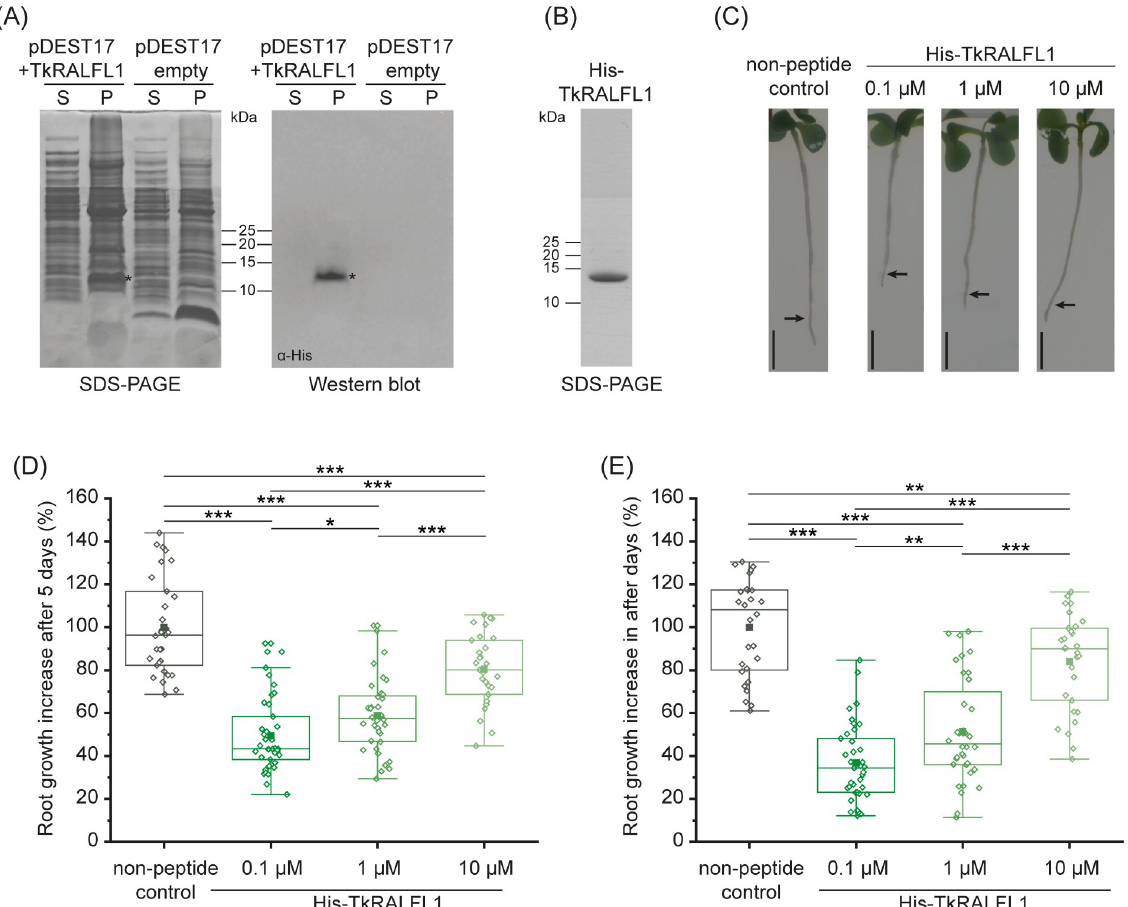
Fig 2. Effect of TkRALF1 produced in E . coli on primary root growth. (A) SDS-PAGE and subsequent western blot analysis (with a His-tag specific antibody) of total protein from E . coli BL21 transformed with either the vector containing His-TkRALFL1 or the empty vector control. For western blot analysis, proteins were transferred to a PVDF membrane and probed using a His-tag specific antibody conjugated to horseradish peroxidase. S, soluble protein phase; P, insoluble protein phase; SDS-PAGE stained with Coomassie Brilliant Blue. The asterisk indicates the additional band in the insoluble phase of E . coli transformed with the expression vector containing His-TkRALFL1. (B) SDS-PAGE analysis of the TkRALFL1 peptide after Ni-NTA affinity purification and subsequent dialysis in order to promote the refolding of the peptide. Gel stained with PageBlue Protein Staining Solution. (C) Representative T . koksaghyz wild-type seedlings from the root growth assay 5 days after transfer to the medium containing different concentrations of TkRALFL1 peptide, that are indicated above the images. Pure buffer was used as non-peptide control. The arrow indicates the position of the root tip at the time of transfer; scale bar = 5 mm. (D) Root growth increase of the primary root of T . koksaghyz wild-type seedlings after treatment for 5 days with different concentrations of exogenous mature TkRALFL1 peptide dissolved in buffer (0.1% (v/v) formic acid). Values were normalized to the mean growth increase of seedlings treated with pure buffer as non-peptide control. The box delimits values from the 25 th to the 75 th percentile of the dataset, the horizontal line in the box represents the median of the data, the filled square represents mean value, and the lower and upper whiskers represent obtained values that differ least from 25 th percentile –1.5 � IQR or 75 th percentile +1.5 � IQR, respectively; n = 28–39, normal distribution proved by Kolmogorov-Smirnov test, statistical significance proved by two-tailed t -test, � p < 0.05, �� p < 0.01, ��� p < 0.001. (E) Root growth increase of the primary root of T . koksaghyz wild-type seedlings after treatment for 10 days as described in Fig 2D. Box plot as described above.